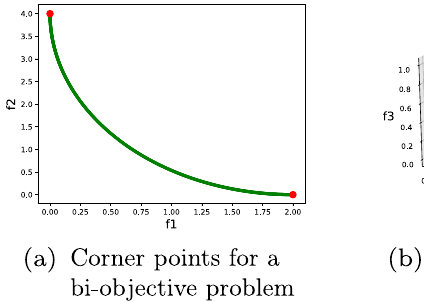
objectives increase, searching for all combinations becomes tedious and impractical. Mostly, the common MOPs have much fewer corners, for e.g., there are M corners for most non-degenerate M -objective problems in DTLZ and WFG benchmarks [8,16]. Considering this, two specific subsets of corners were deemed to be of interest in [31]: Type-1 cor- ners , that only minimize one objective value (Fig.2c), and Type-2 corners , that minimize M − 1 objectives simultane- ously